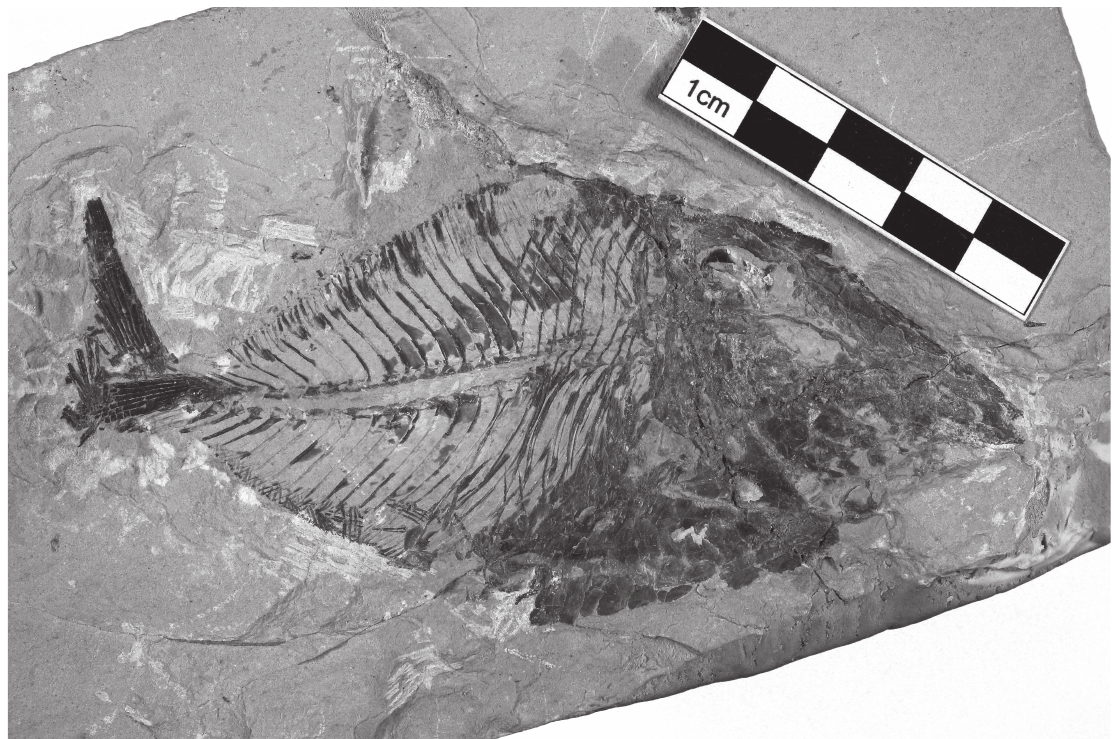
Fig. 4. Acrorhinichthys poyatoi gen. et sp. nov. Paratype CLC S-1098.